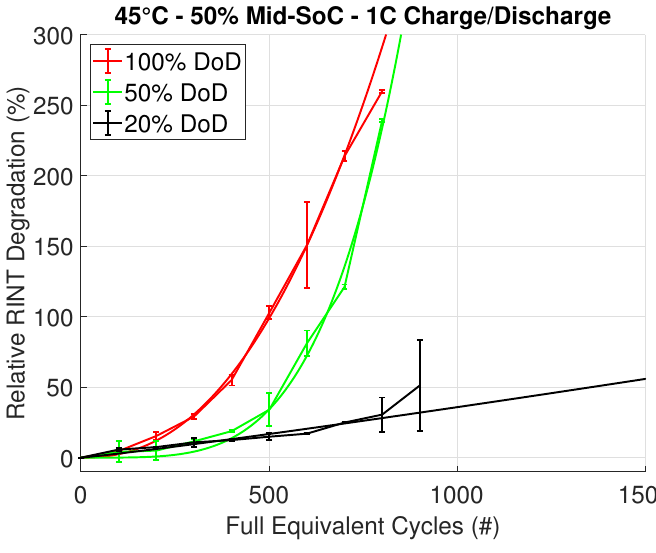
Figure 5. The 45 °C extrapolation